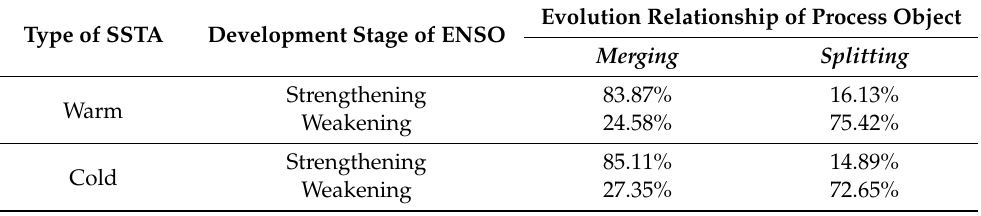
Table 5. Relationships between the development of ENSO with an evolution of SSTA. Warm SSTA refers to El Niño and cold SSTA to La